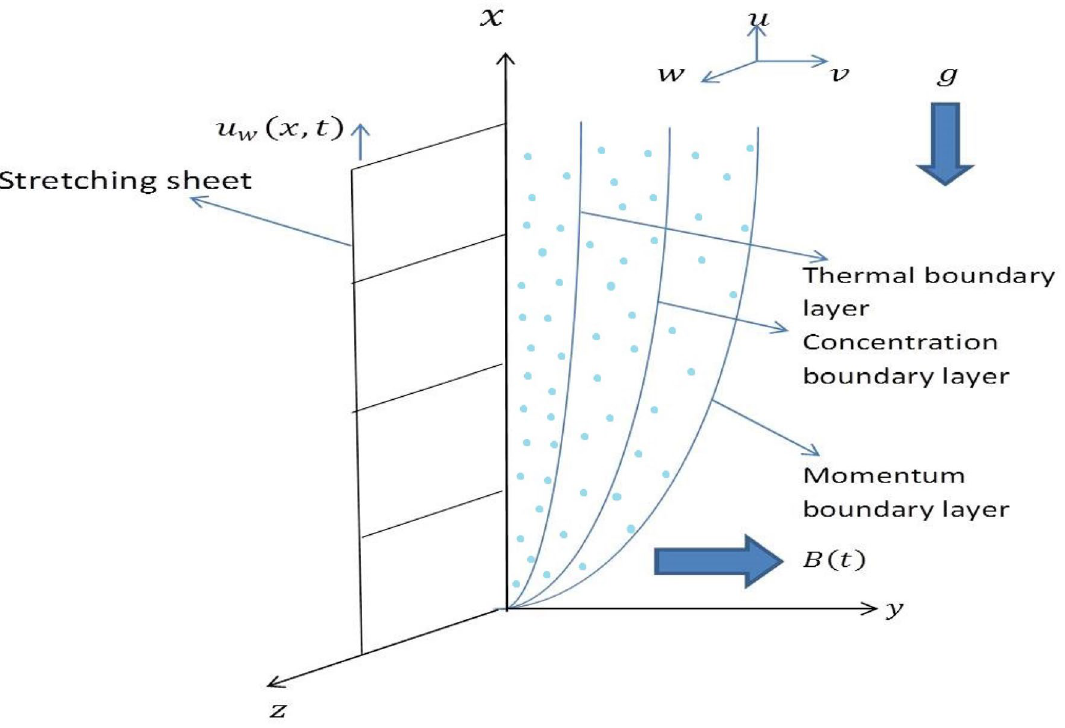
Figure 1. The schematic diagram of the physical